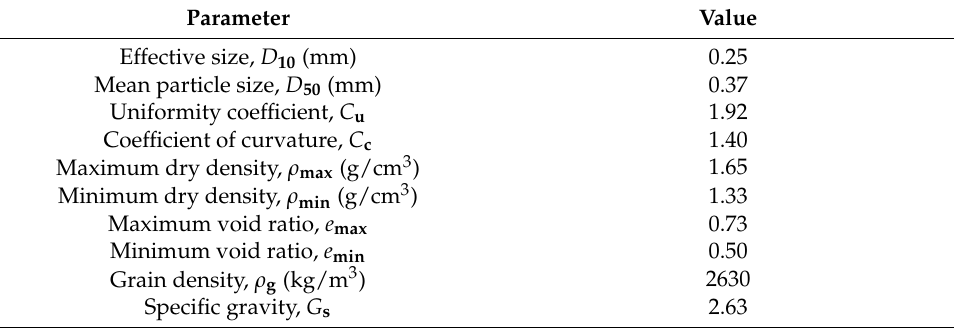
Table 1. Physical properties of Fujian standard